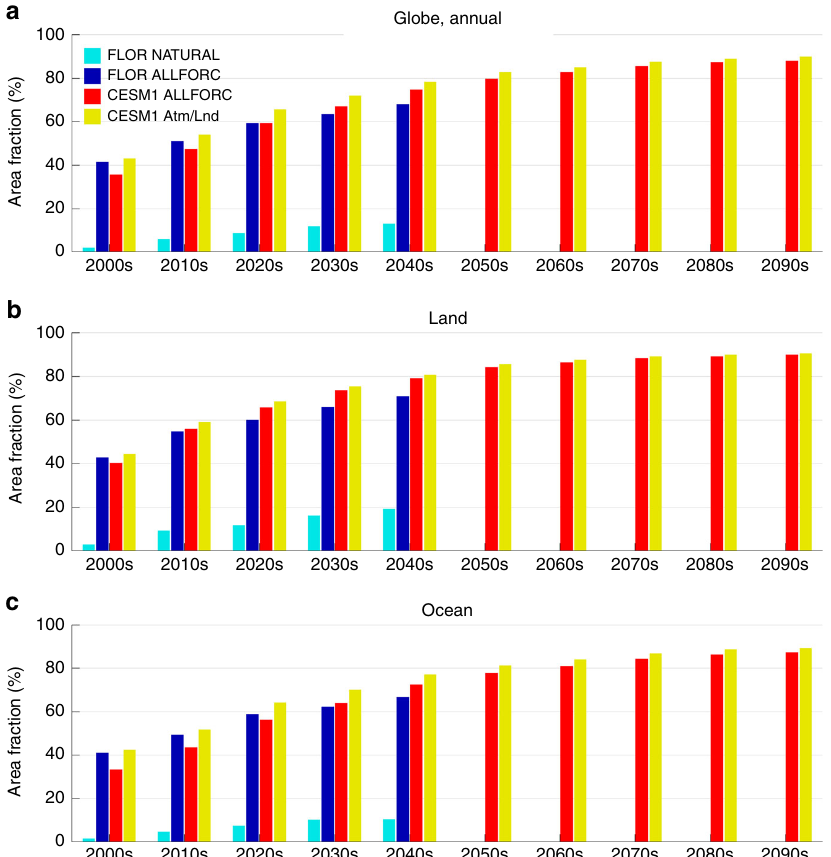
Fig. 2 Fraction of area with distinguishable changes in annual precipitation mean state. a total global area, b global land, and c global ocean. Cyan, blue, and red bars show fraction of area with distinguishable changes against fully coupled internal climate variability in FLOR NATURAL, ALLFORC, and CESM1 ALLFORC, respectively, while yellow bars denote that in CESM1 ALLFORC against atmosphere/land-only internal climate